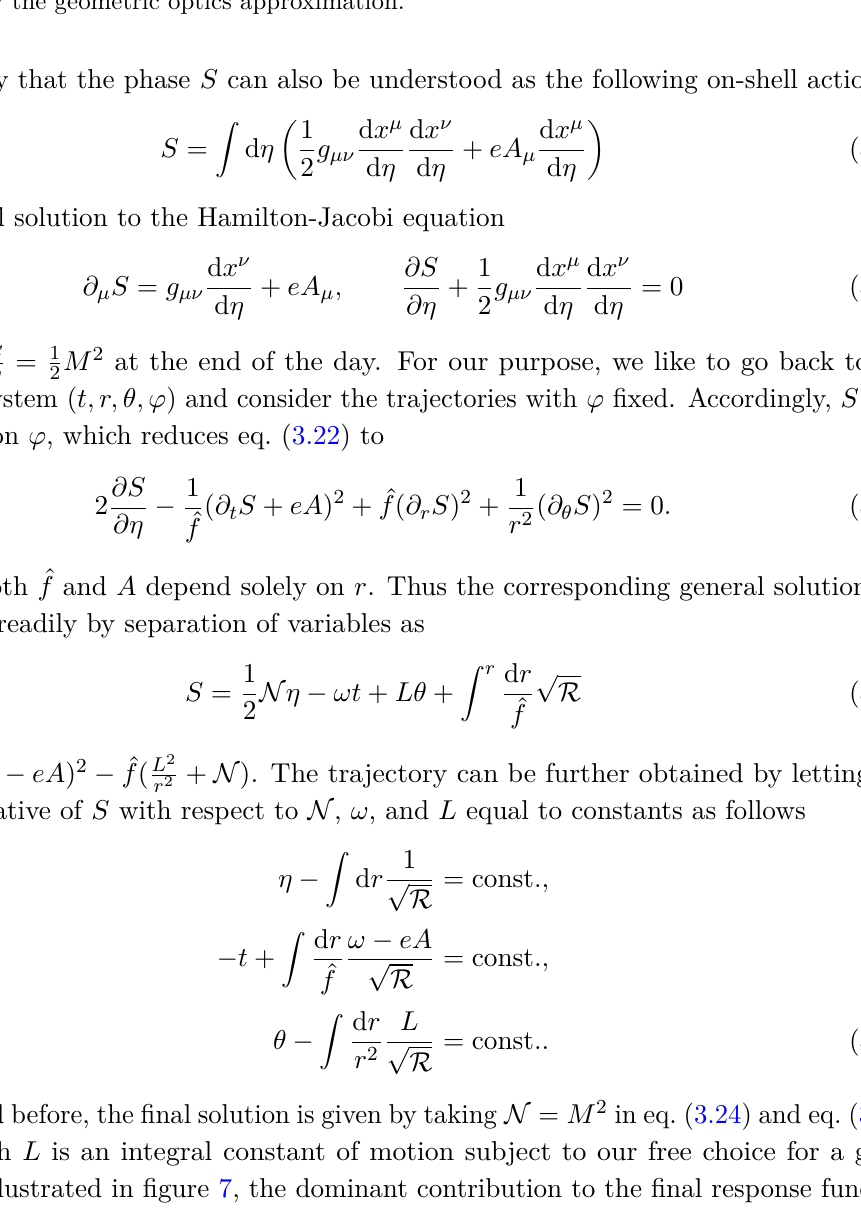
Figure 6 . The image of the lensed response on the screen at T = 1 /π and µ = 2 for different frequencies, where r R of the sharp Einstein ring for ω = 75 is around 0 . 984 , in good agreement with f 0 . 996 given by the geometric optics